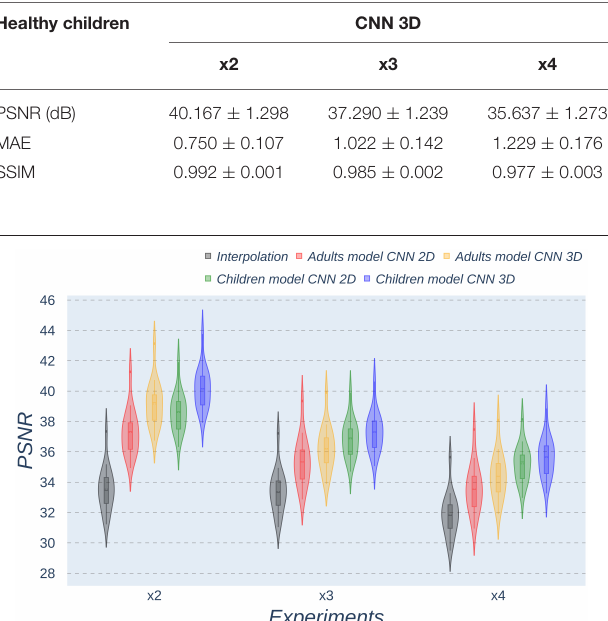
TABLE 4 | Results for different metrics and scaling factors among healthy children test set using 3D CNN method.